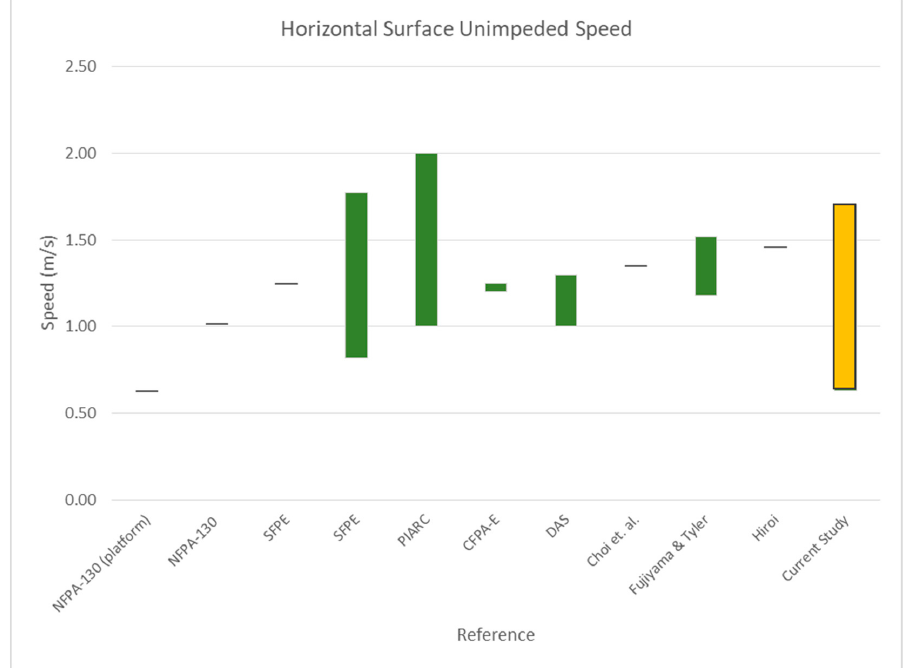
Figure 20. Walking speed (m/s) during unimpeded travelling in horizontal surface synopsis, database from previous studies and current experiment.